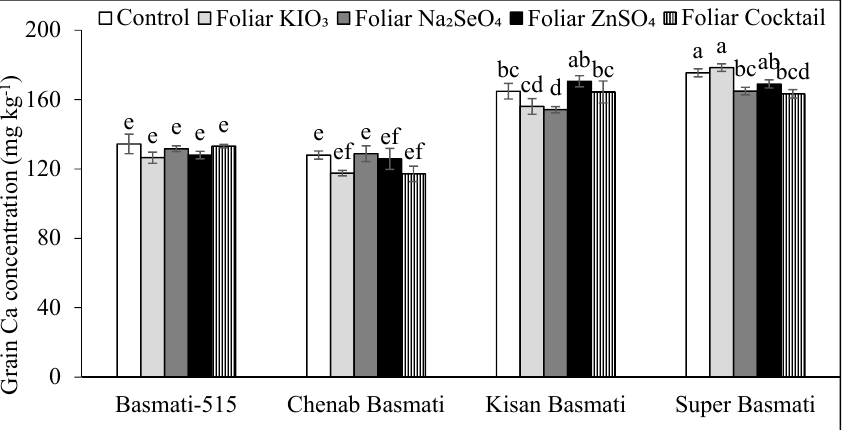
Figure 3. Effect of foliar sprays of KIO 3 (0.05%), Na 2 SeO 4 (0.0024%), and ZnSO 4 ∙ 7H 2 O (0.5%) alone or together as a cocktail on Ca concentration in brown rice grains of different Basmati rice cultivars. Control, two foliar sprays of distilled water; Foliar KIO 3, two foliar sprays of 0.05% KIO 3; Foliar Na 2 SeO 4 , two foliar sprays of 0.0024% Na 2 SeO 4 ; Foliar ZnSO 4 , two fo- liar sprays of 0.5% ZnSO 4 ∙ 7H 2 O; Foliar Cocktail, two foliar sprays of a mixture of 0.05% KIO 3 , 0.0024% Na 2 SeO 4 and 0.5% ZnSO 4 ∙ 7H 2 O. Data bars (mean ± SE) having different letters differ significantly at p = 0.05. LSD: Cultivar = 4.37, Treatment = NS, Cultivar × Treatment = 9.76.